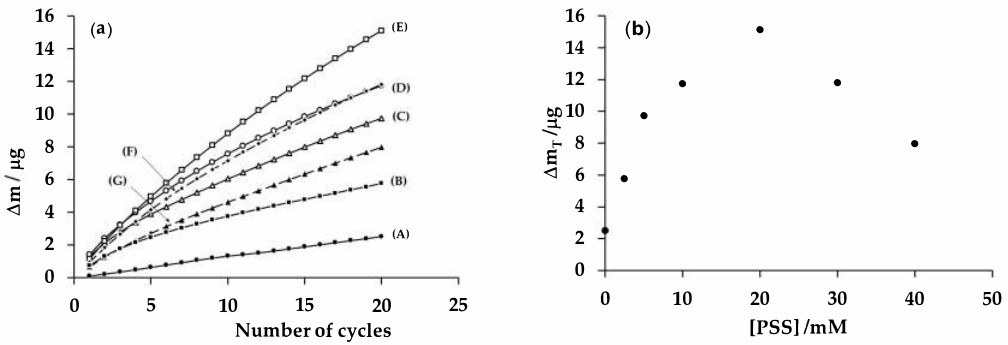
Figure 3. ( a ) Curves of the mass shifts ( ∆ m) as a function of the number of potential sweep cycles, carried out during the electrosynthesis of the PAni / PSS composite deposits at di ff erent concentrations of PSS in solution: (A) 0, (B) 2.5, (C) 5, (D) 10, (E) 20, (F) 30 and (G) 40 mM. ( b ) The total mass ( ∆ M T ) of PAni / PSS composite as a function of the PSS concentration in the work